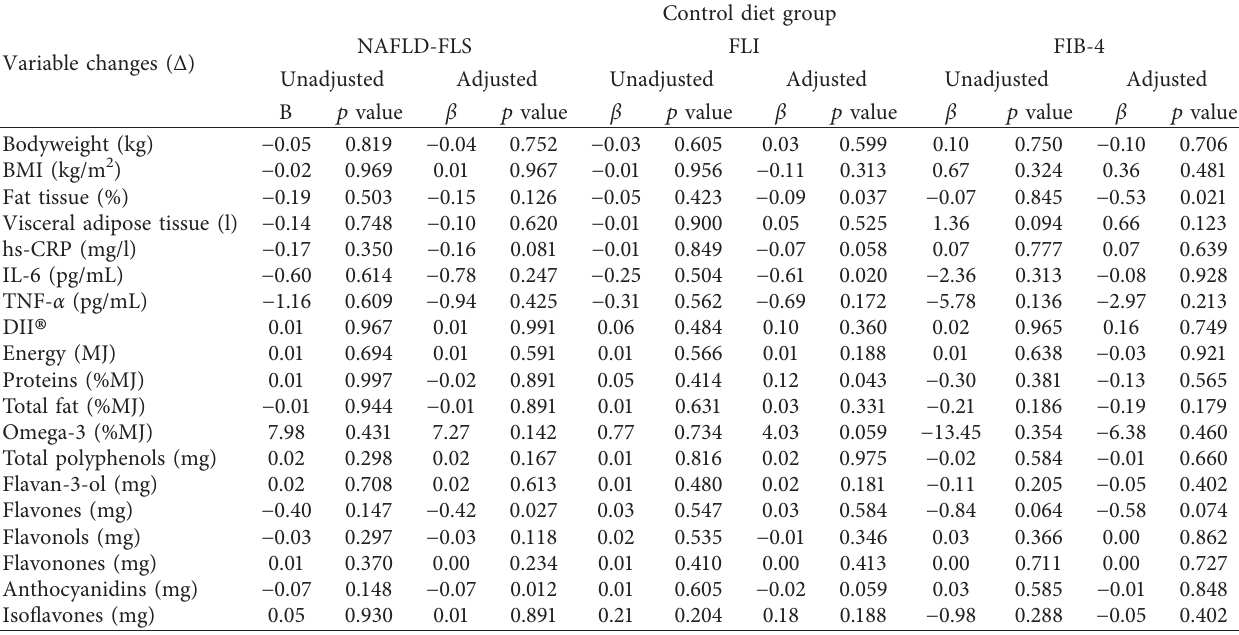
Table 5: Regression analyses of the hepatic status parameters after 6months of dietary intervention as dependent variables and changes in anthropometric, biochemical, and dietary factors as independent variables in the CD group a